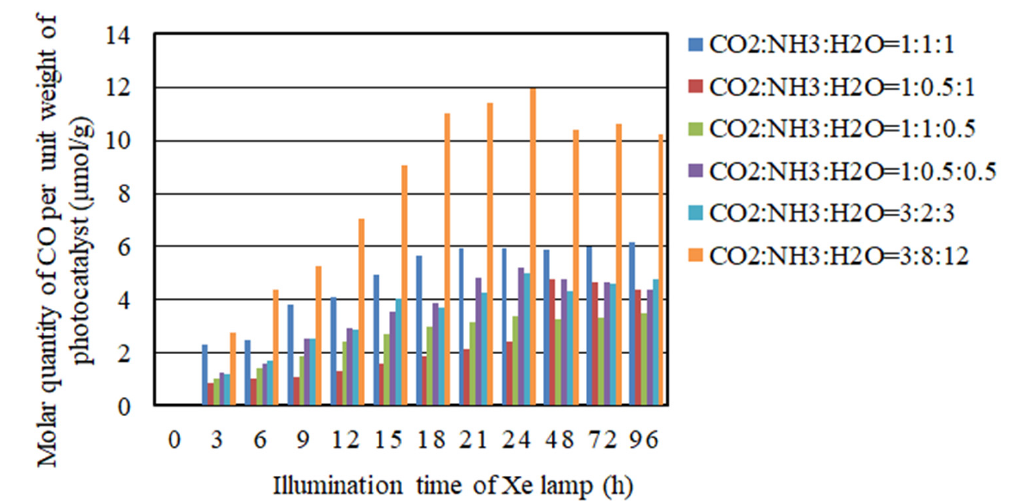
Figure 5. Comparison of molar quantity of CO per unit weight of photocatalyst under the illumination condition of Xe lamp without UV light. The pulse number is 200. The highest CO 2 reduction characteristic is obtained under the condition of the molar ratio of CO 2 /NH 3 /H 2 O = 3:8:12 where the molar quantity of CO per unit weight of photocatalyst is 12.0 mol/g.